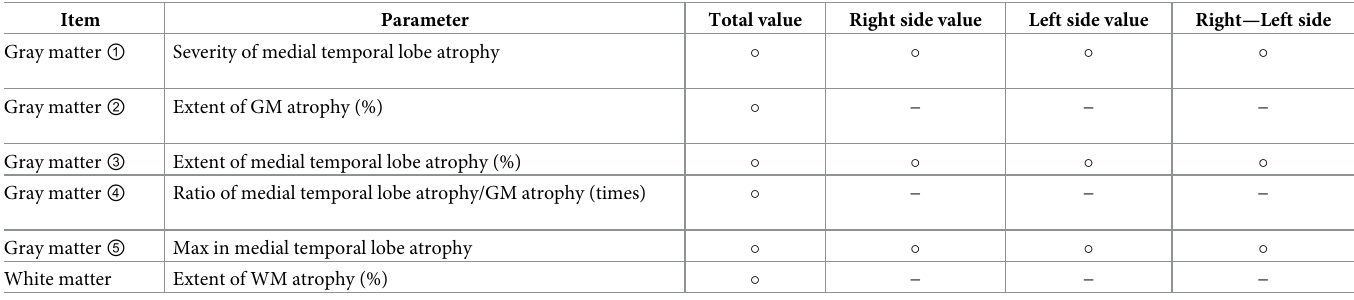
Table 2. Results calculated by